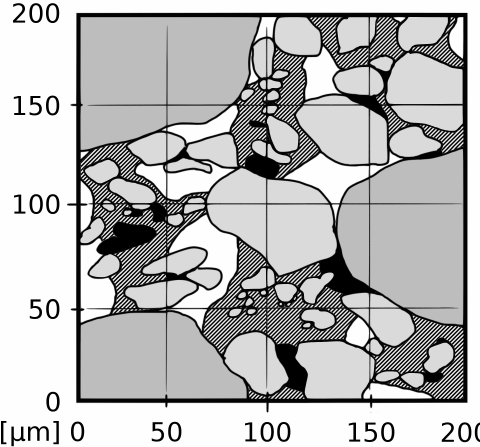
Figure 1. Proposed model of aggregate structure including biofilms in a soil aggregate: sand and silt (both grey) and organic parti- cles (black) stick together by physico-chemical interactions and are bridged by EPS (striped), which additionally stabilizes the soil ag- gregate structure and the pore space